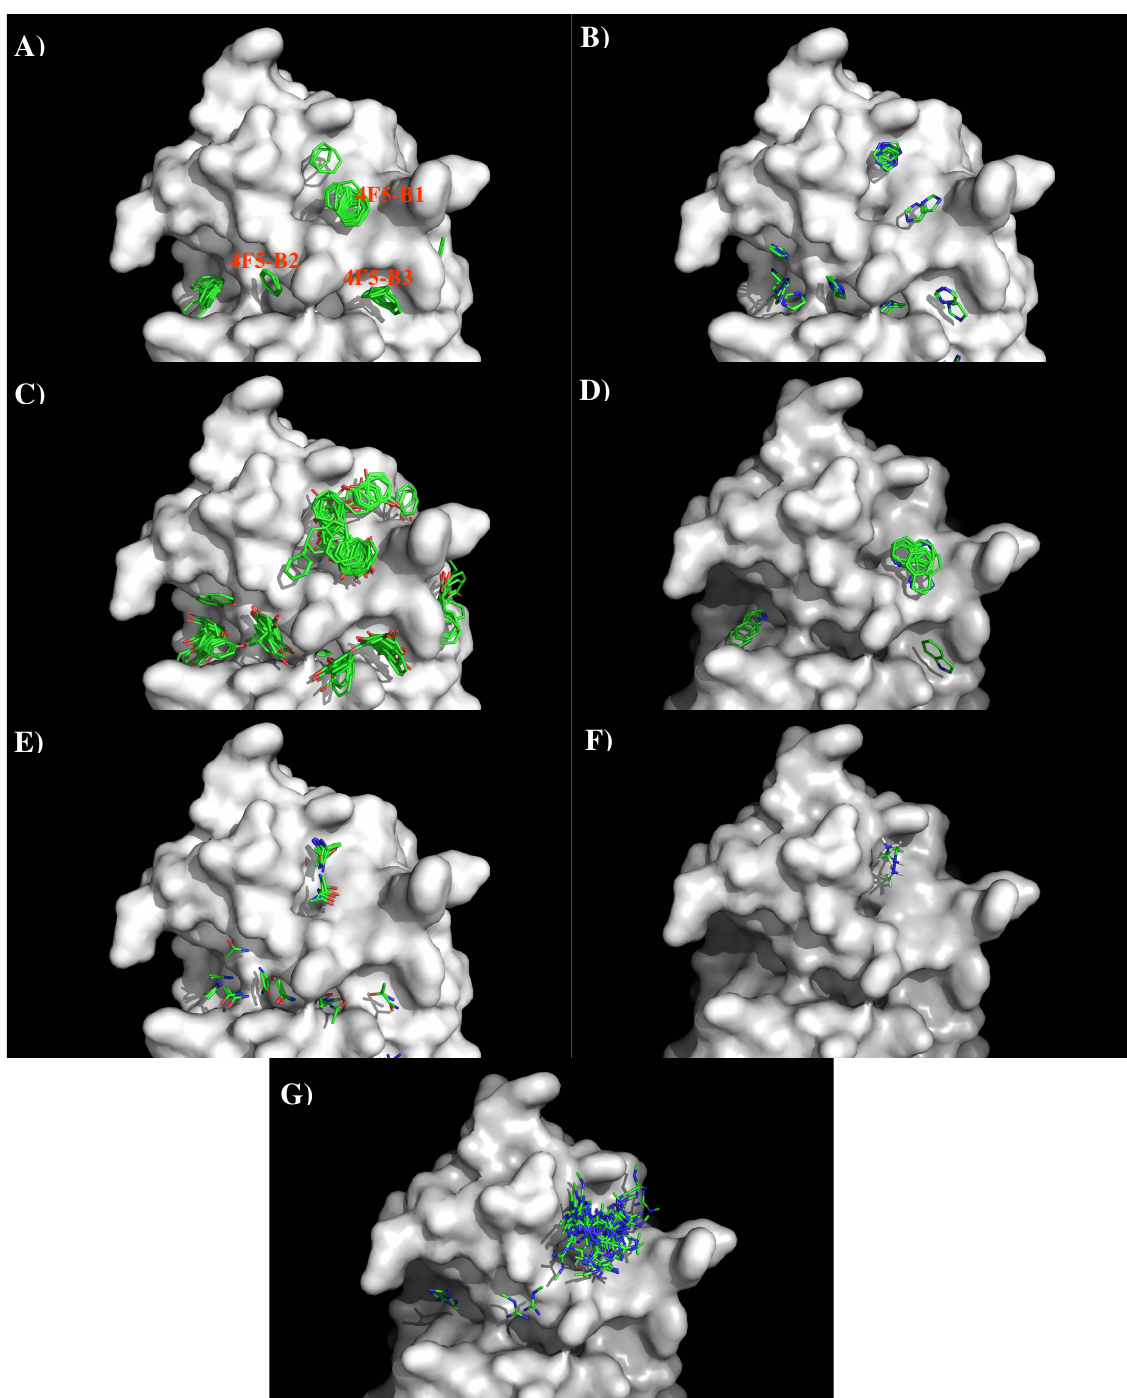
Figure 11. Selected MCSS minima of functional groups on the surface of antibody 4F5. ( A ) BENZ; ( B ) IMIAl ( C ) PHEN; ( D ) INDO; ( E ) ACEM; ( F ) MAMM; ( G ) MGUA. Figures were prepared using PyMOL